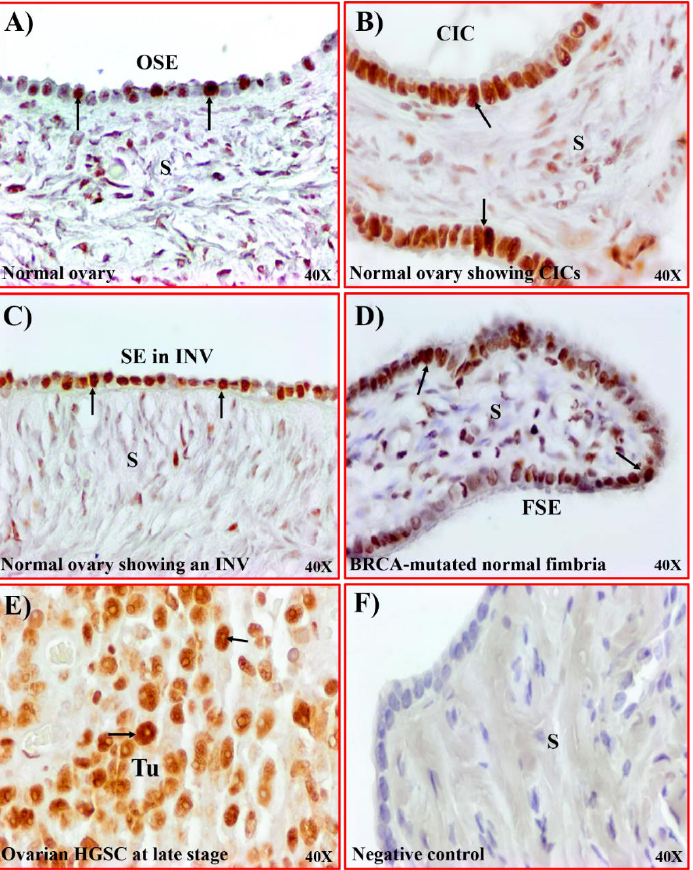
Figure 4. Expression of nucleolin by ovarian CICs and INVs. ( A ) Section of a normal ovary showing nucleolin expression by a few OSE cells. ( B ) Section of a normal ovary showing intense expression of nucleolin by the tube-like epithelial cells of the stromal CICs. ( C ) Section of a normal ovary show- ing nucleolin expression by the epithelial cells in a stromal invagination (INV). ( D ) Section of an oviductal fimbria from a BRCA+ woman showing nucleolin expression by the fimbrial surface epi- thelial (FSE) cells. ( E ) Section of an ovarian HGSC showing intense expression of nucleolin by the malignant cells. ( F ) Section of a normal ovary immunostained by omitting primary antibodies (neg- ative control) in which no staining for nucleolin is observed. Arrows indicate a positive stain. S = stroma, SE = surface epithelium, Tu = tumor. Magnification = 40X. 3.4. Nucleolin Expression in Hens A few surface epithelial cells in the oviductal fimbria of healthy hens showed very weak staining for nucleolin (Figure 5A). In normal ovaries, nucleolin expression in OSE cells was mainly localized in areas close to stromal follicles (Figure 5B). In contrast, strong staining for nucleolin was observed in tumors limited to the fimbria (Figure 5C) as well as in ovaries with HGSC (Figure 5D). The intensity of nucleolin was 5.4 × 10 3 ± 0.3 × 10 3 and 6.8 × 10 3 ± 0.6 × 10 3 in 20,000 µm 2 in normal fimbriae and ovaries, respectively (Figure 5E,F). Compared with normal tissues, the intensity of nucleolin expression was approxi- mately 2-fold greater in fimbriae with early-stage tumor ( P < 0.05) and 1.6-fold greater in ovaries with early-stage tumor ( P < 0.05). At late stages of ovarian HGSC, the intensity of